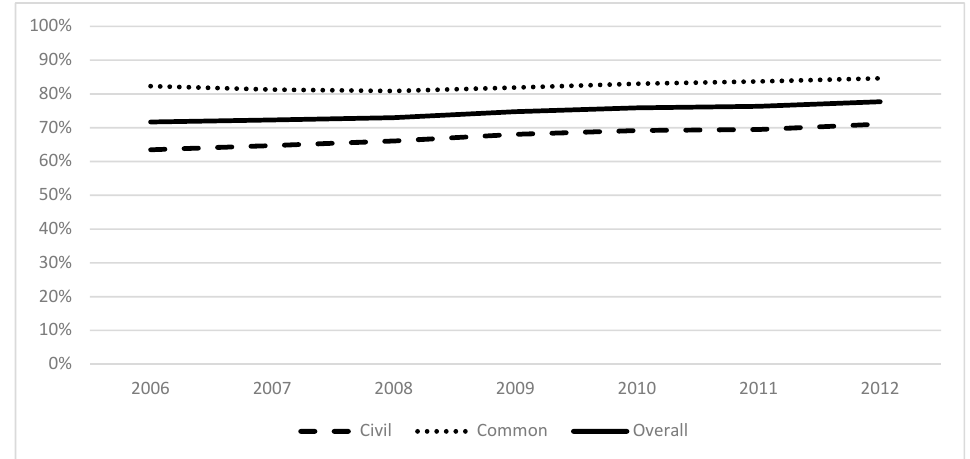
Figure 2. Weighted Average of Board Attributes Index (GOV 14 ).